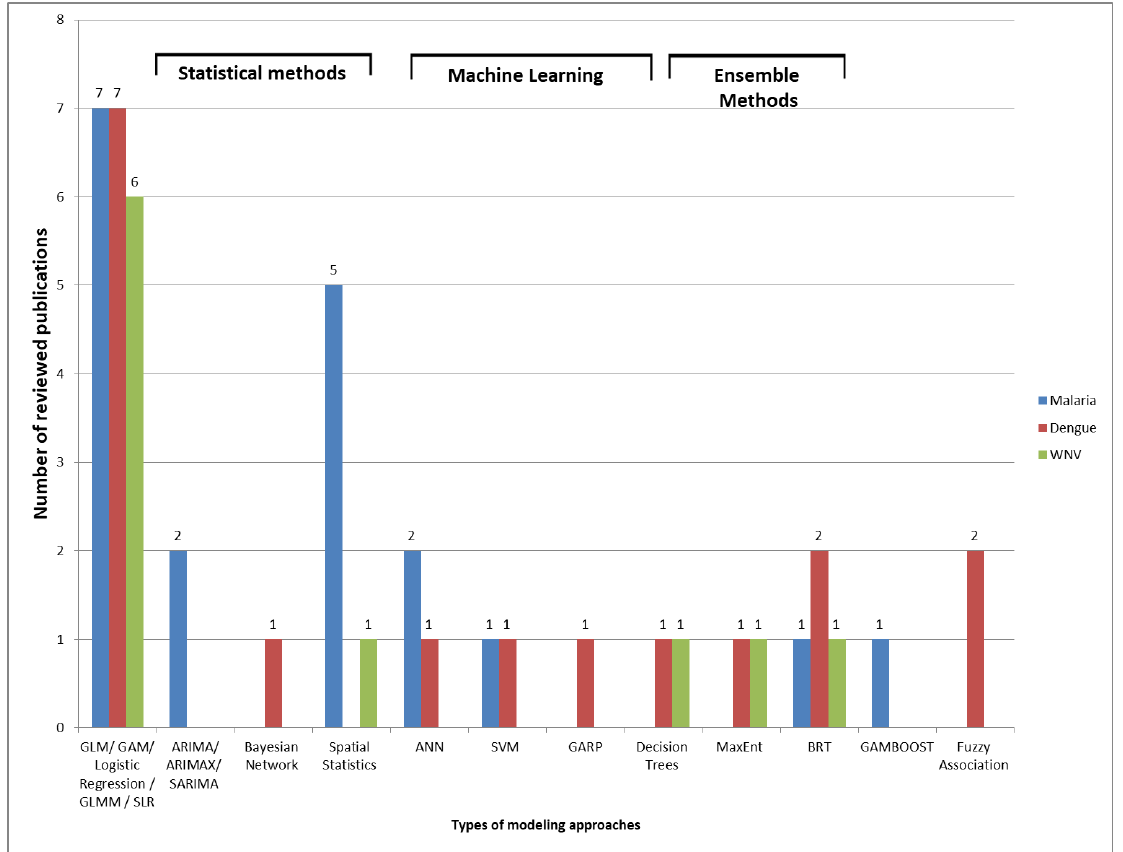
Figure 5. Overview of the methods that were considered in this